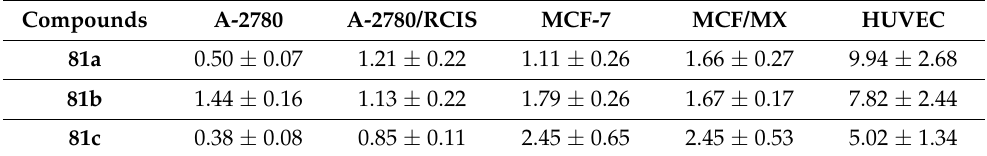
Table 5. Antiproliferative activity of compound 83a – c measured in IC 50 values ( µ